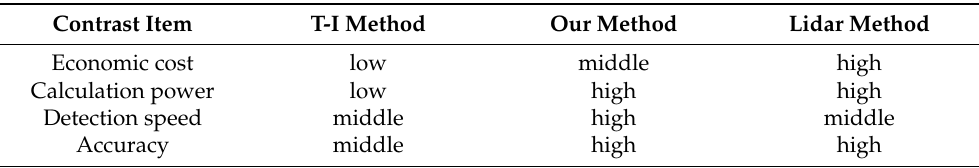
Table 6. Performance comparison of different types of